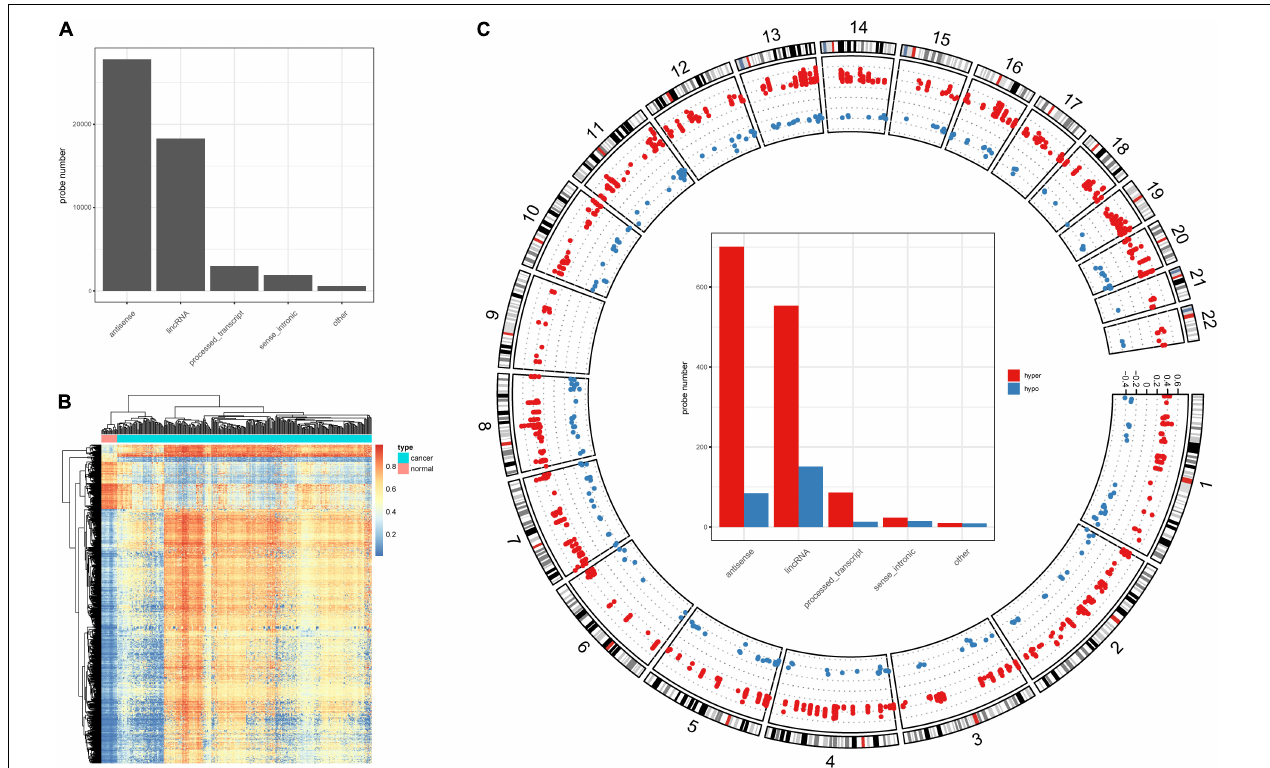
FIGURE 1 | DNA methylation character in lncRNA promoters. (A) Probe number in each lncRNA class. (B) Heatmap of the DMSs in lncRNA promoters. (C) Circos plot of the hyper- and hypo DMSs; y -axis shows the methylation difference level, inside bar plot represent the hyper- and hypo DMSs statistics in each lncRNA